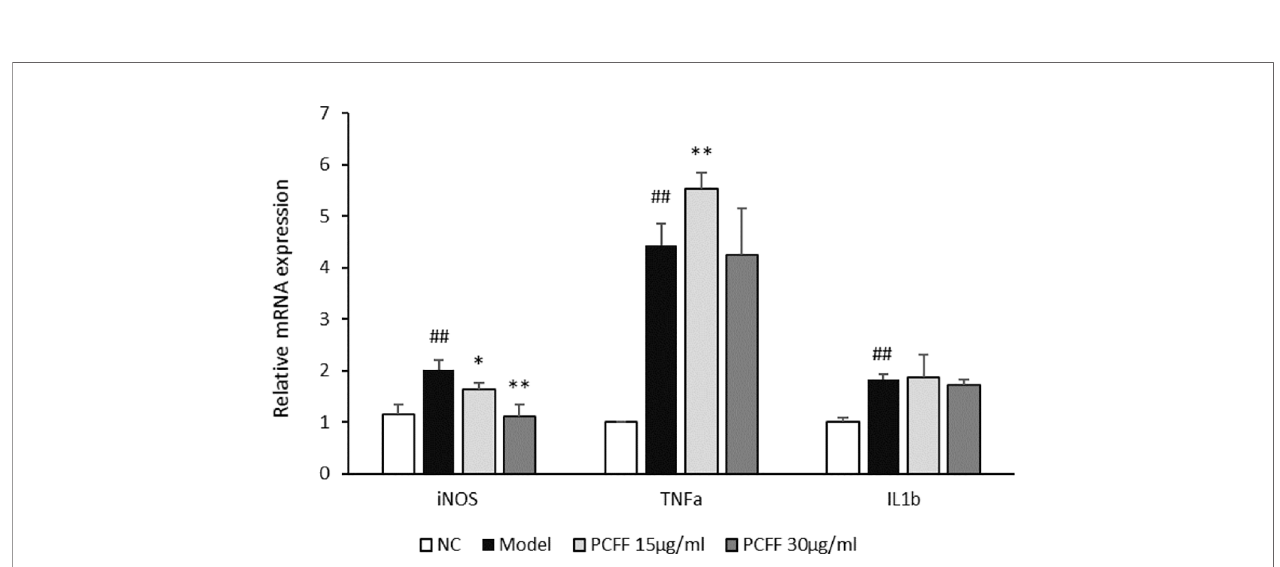
FIGURE 4 | Inhibitory effect of PCFF on expression of iNOS 、 TNF- a and IL-1 b mRNA. Each value indicates the mean ± SD from three independent experiments. Compared with normal group, ## P < 0.01; compared with control group, *P < 0.05, **P < 0.01. NC group untreated; Model group cut tail; PCFF group added different dose PCFF after cut tail.